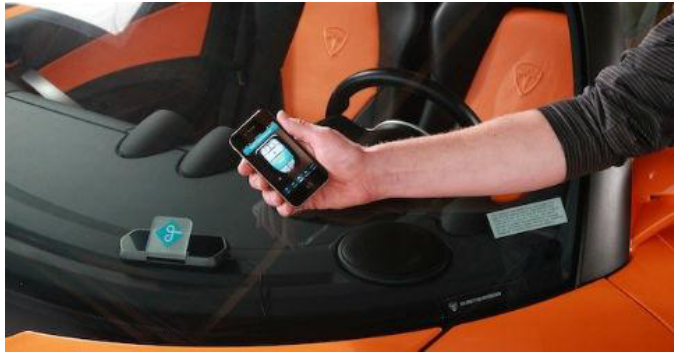
Figure 8. Keyless Authentication and Vehicle Access. Image credit: Getaround